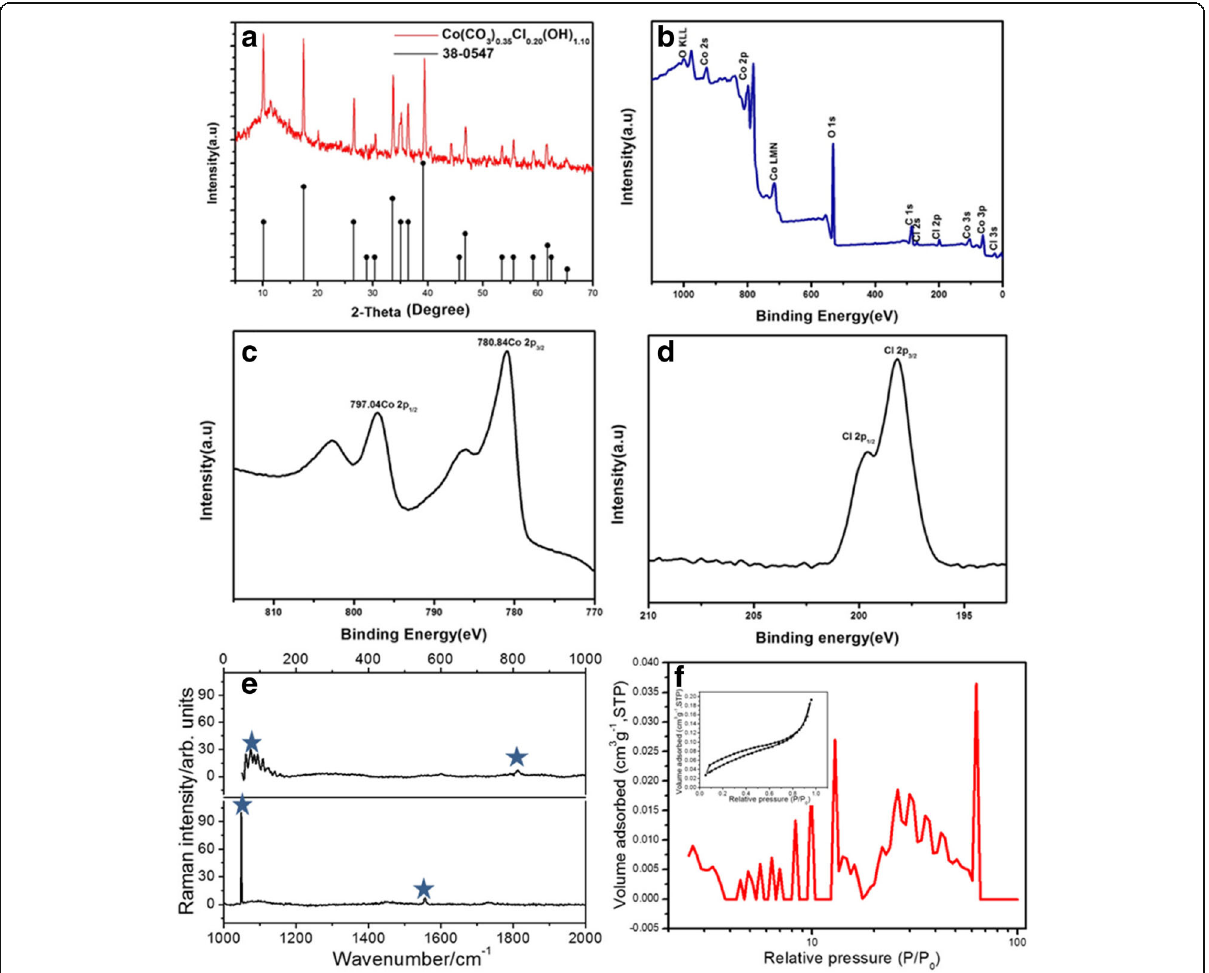
Fig. 4 a XRD pattern, b XPS survey spectrum, c high resolution of Co 2p spectrum, d high resolution Cl 2p spectrum, e Raman spectrum, and f QSDFT pore size distribution (inset: N2 absorption/desorption isotherms) of